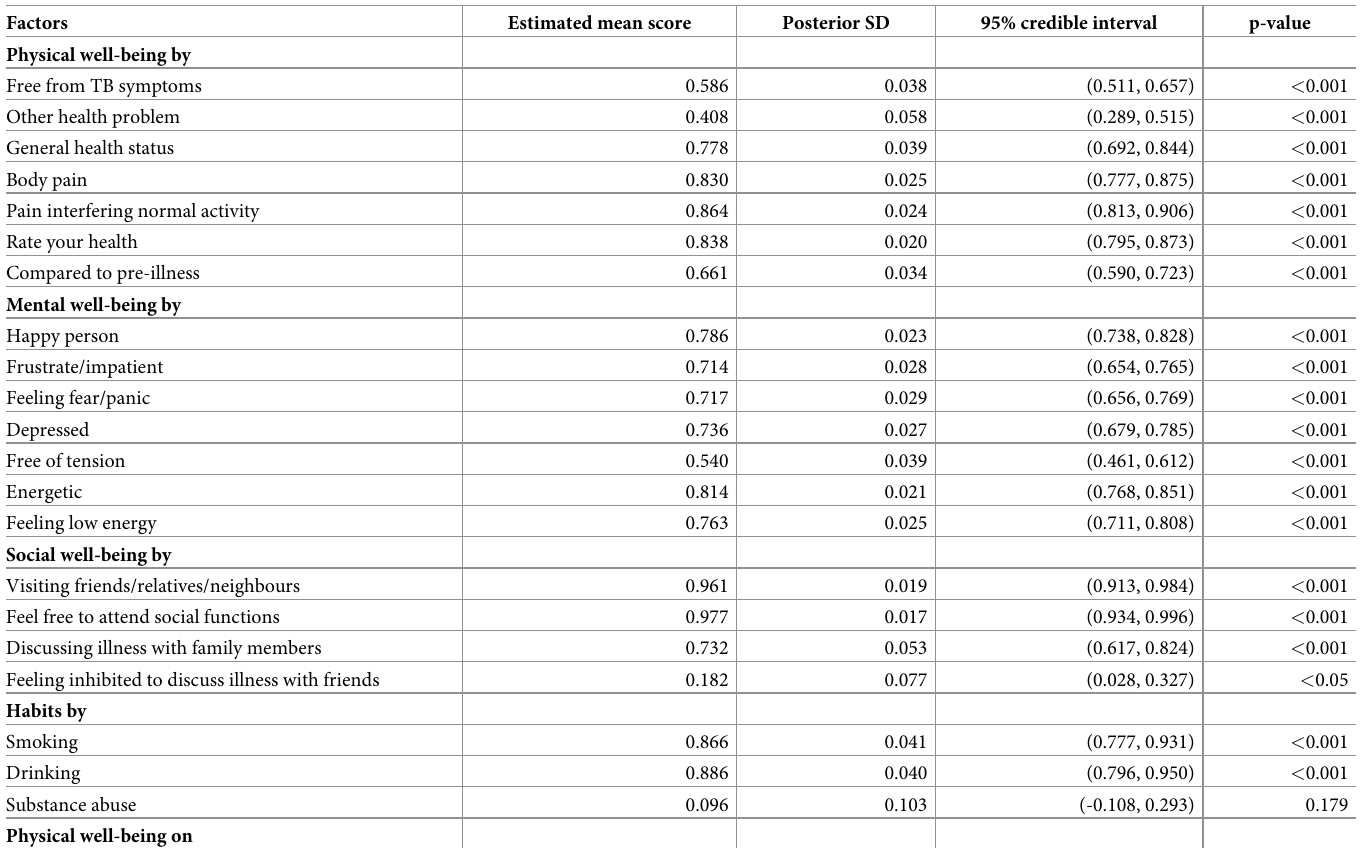
Fig 1. Path diagram for HRQoL of TB patients. Legend: pw- Physical well- being, mw-Mental well-being, sw-Social well-being, occu–Occupation, subsabus–substance abuse, smoke–smoking habits, tpqol–Health Related Quality of Life of tuberculosis patients. https://doi.org/10.1371/journal.pone.0252205.g001 Table 2. Parameter estimates of measurement model for HRQoL of TB